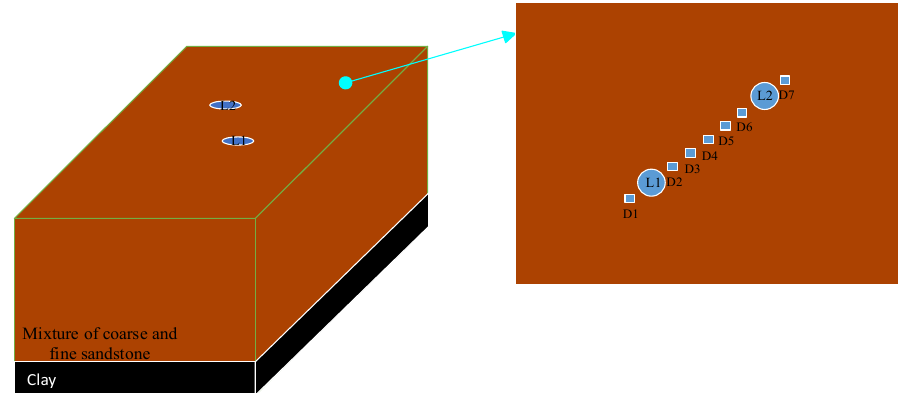
Figure 1. Experimental equipment layout schematic diagram.